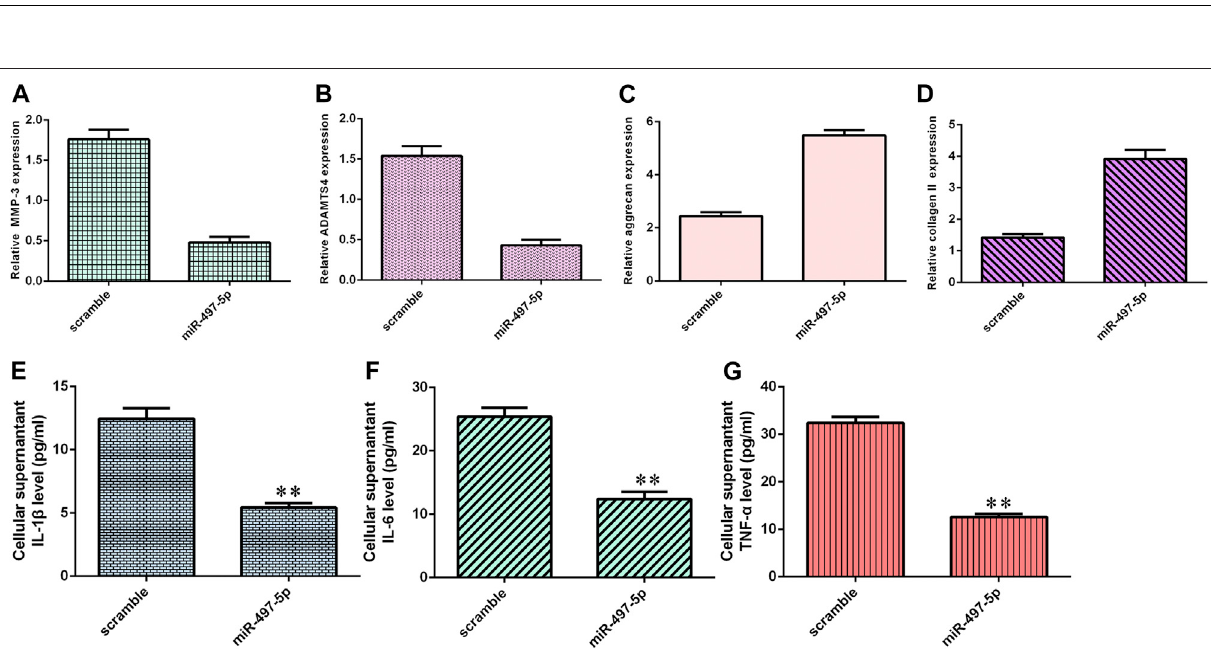
Frontiers in Molecular Biosciences |